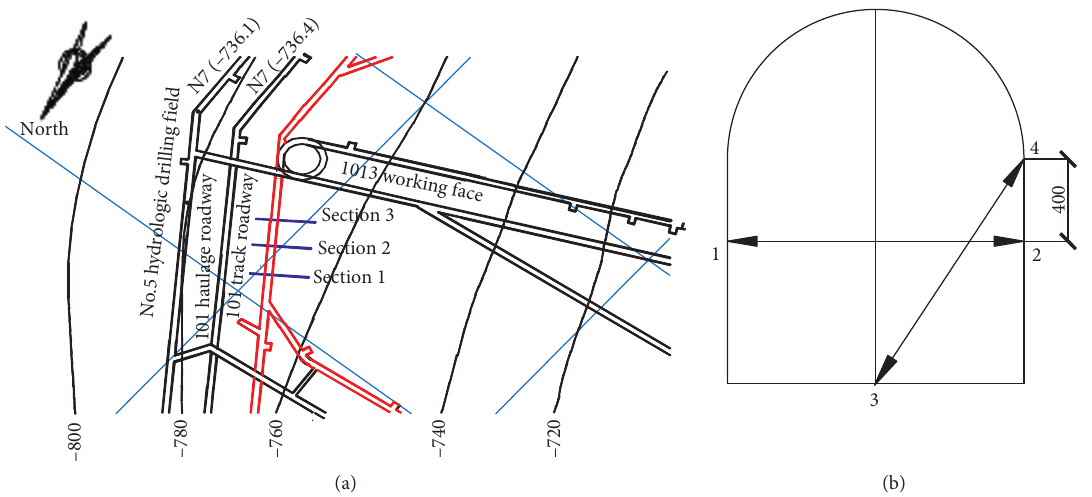
Figure 14: Schematic diagram of detection section site layout.